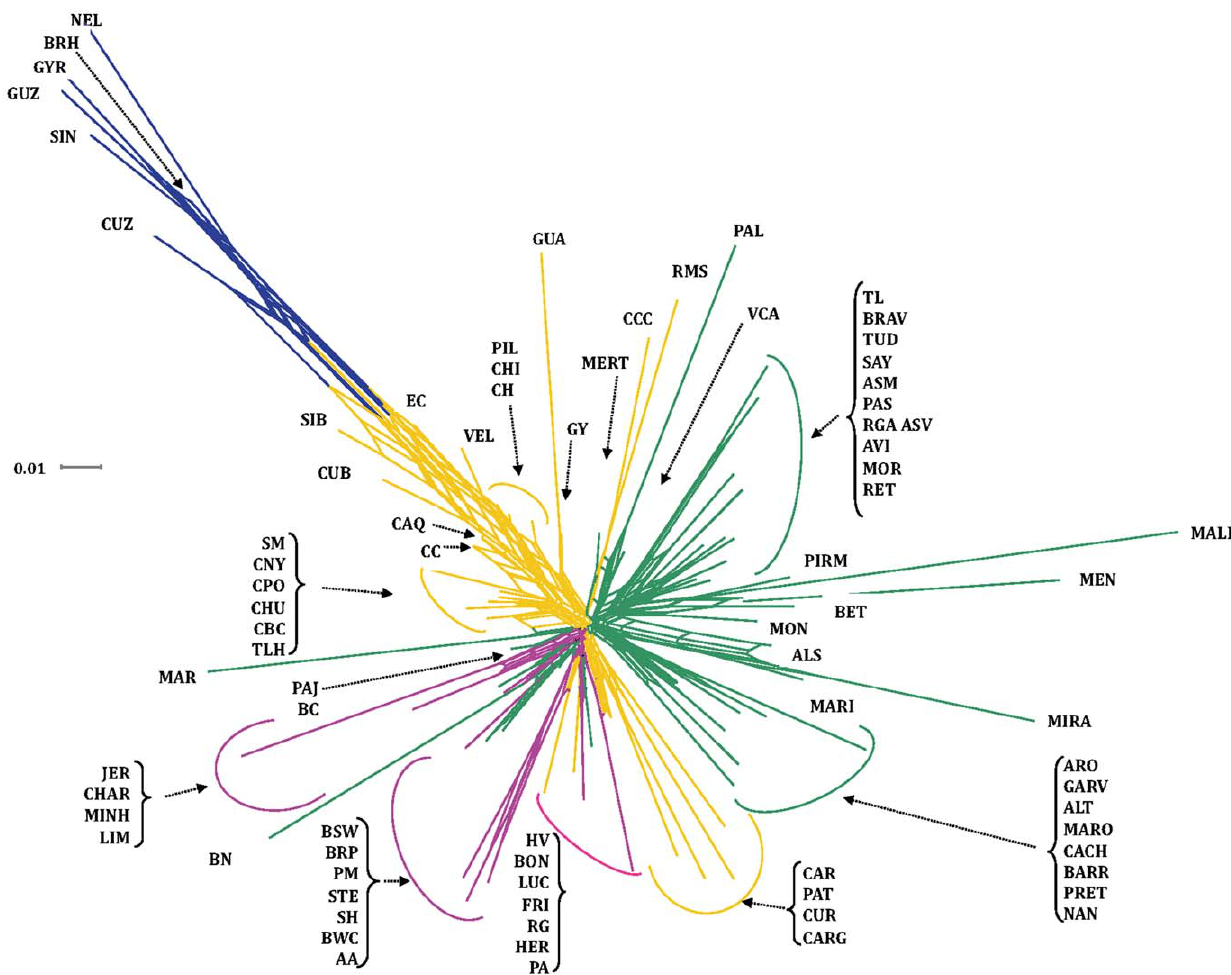
Figure 3. Neighbor-net dendrogram constructed from the Reynolds genetic distances among 81 cattle breeds. Yellow: Creole; Green: Iberian; Pink: British and Continental European; Blue: Indian Zebu. SPANISH . Betizu (BET), Toro de Lidia (TL), Menorquina (MEN), Alistana (ALS), Sayaguesa (SAY), Tudanca (TUD), Asturiana de los Valles (ASV), Asturiana de las Montan˜as (ASM), Retinta (RET), Morucha (MOR), Avilen˜a (AVI), Pirenaica (PIRM), Rubia Gallega (RGA), Mallorquina (MALL), Monchina (MON), Serrana de Teruel (STE), Parda de Montan˜a (PM), Bruna de los Pirineos (BRP), Pasiega (PAS), Berrenda en Colorado (BC), Berrenda en Negro (BN), Marismen˜a (MAR), Pajuna (PAJ), Negra Andaluza (NAN), Vaca Canaria (VCA), Vaca Palmera (PAL); PORTUGUESE . Alentejana (ALT), Arouquesa (ARO), Barrosa˜ (BARR), Brava de Lide (BRAV), Cachena (CACH), Garvonesa (GARV), Marinhoa (MARI), Maronesa (MARO), Mertolenga (MERT), Minhota (MINH), Mirandesa (MIRA), Preta (PRET), Ramo Grande (RG); CREOLE . Guabala´ (GUA), Guaymı´ (GY), Texas Longhorn (TLH), Criollo Poblano (CPO), Criollo de Baja California (CBC), Criollo de Chihuahua (CHU), Criollo de Nayarit (CNY), Criollo de Chiapas (CHI), Blanco Orejinegro (BON), Caqueten ˜ o (CAQ), Sanmartinero (SM), Romosinuano (RMS), Costen ˜ o con Cuernos (CCC), Chino Santandereano (CH), Velasquez (VEL), Lucerna (LUC), Harto´n del Valle (HV), Criollo Casanaren˜o (CC), Criollo Ecuatoriano (EC), Criollo Uruguayo (CUR), Pampa Chaquen˜o (PA), Criollo Pilcomayo (PIL), Criollo Argentino (CARG), Criollo Patago´nico (PAT), Caracu´ (CAR), Cubano (CUB), Siboney (SIB); ZEBU : Gyr (GYR), Brahman (BRH), Sindi (SIN), Guzerat (GUZ), Nelore (NEL), Zebu Cubano (CUZ); Other EUROPEAN. Friesian (FRI), Hereford (HER), Brown Swiss (BSW), Aberdeen Angus (AA), British White (BWC), Charolais (CHAR), Jersey (JER), Limousin (LIM), Shorthorn (SH).